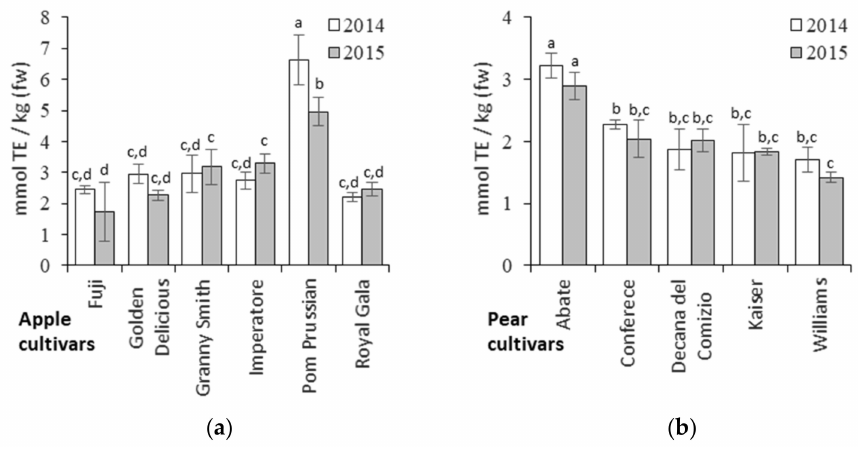
Figure 6. FRAP assay to measure the antioxidant activity of different apple ( a ) and pear ( b ) cultivars in different seasons. TE = Trolox equivalents. Data are means ± standard deviations of n = 3 samples. Different letters on bars indicate that means are significantly different according to post-hoc SNK-ANOVA ( p < 0.05).